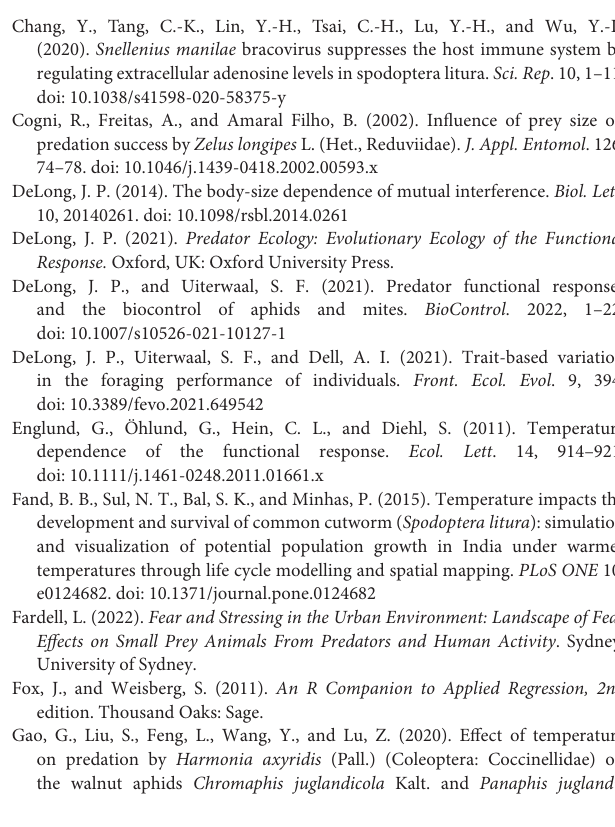
FIGURE 6 | data ( n = 10,000). Different lowercase letters above the caps indicate significant differences in H. axyridis stages among the temperatures according to 95% CI. Number of replications (N) =